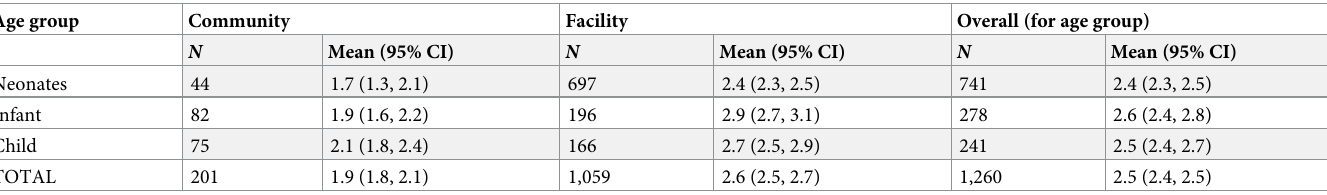
Table 4. Mean number of conditions in the causal chain for each age group by whether the death occurred in the community or in a healthcare facility. Age group AU : PleasenotethatasperPLOSstyle ; italicsshouldnotbeusedforemphasis : Community